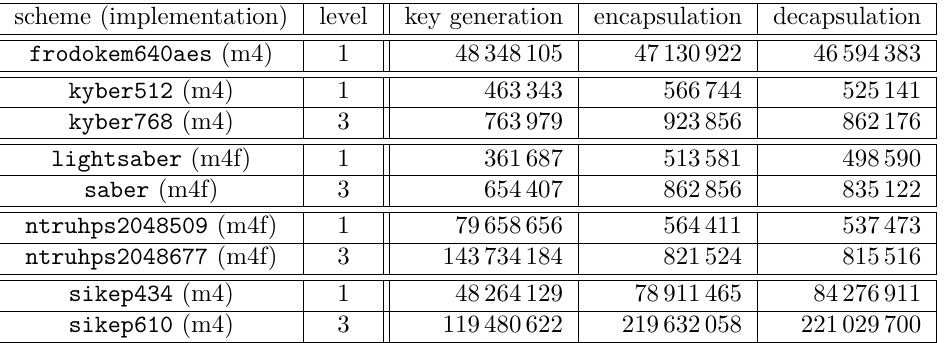
Table 10: Performance numbers of the 3rd-round KEMs from pqm4 commit-6841a6b. scheme (implementation)